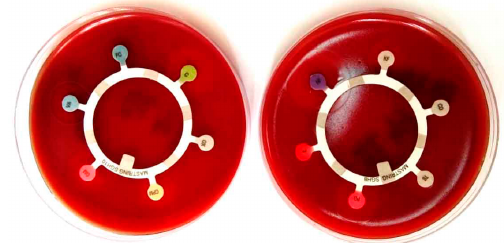
Fig. 3. The combination disk diffusion test of Enterococcus strain with some Table 2. Antimicrobial resistance profiles of the 19 Enterococcus isolates Isolates